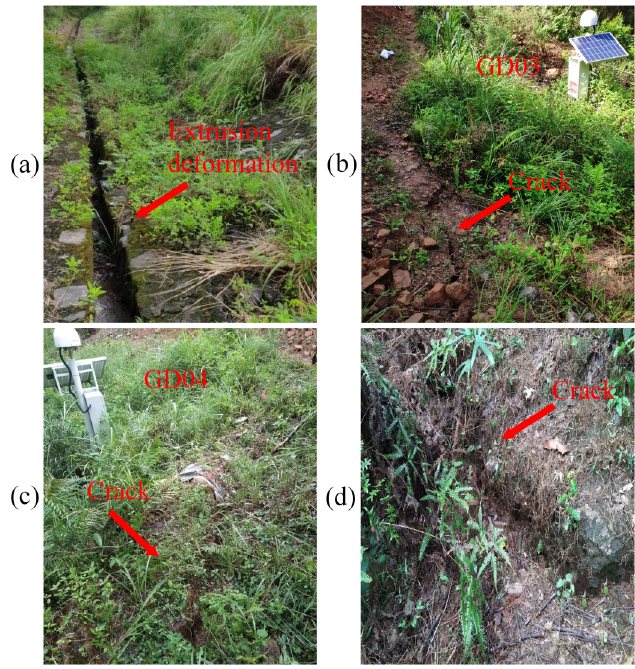
Figure 12. Field inspection photos. ( a ) Around the station of GD01. ( b ) Station of GD03. ( c ) Station of GD03. ( d ) Around the station of